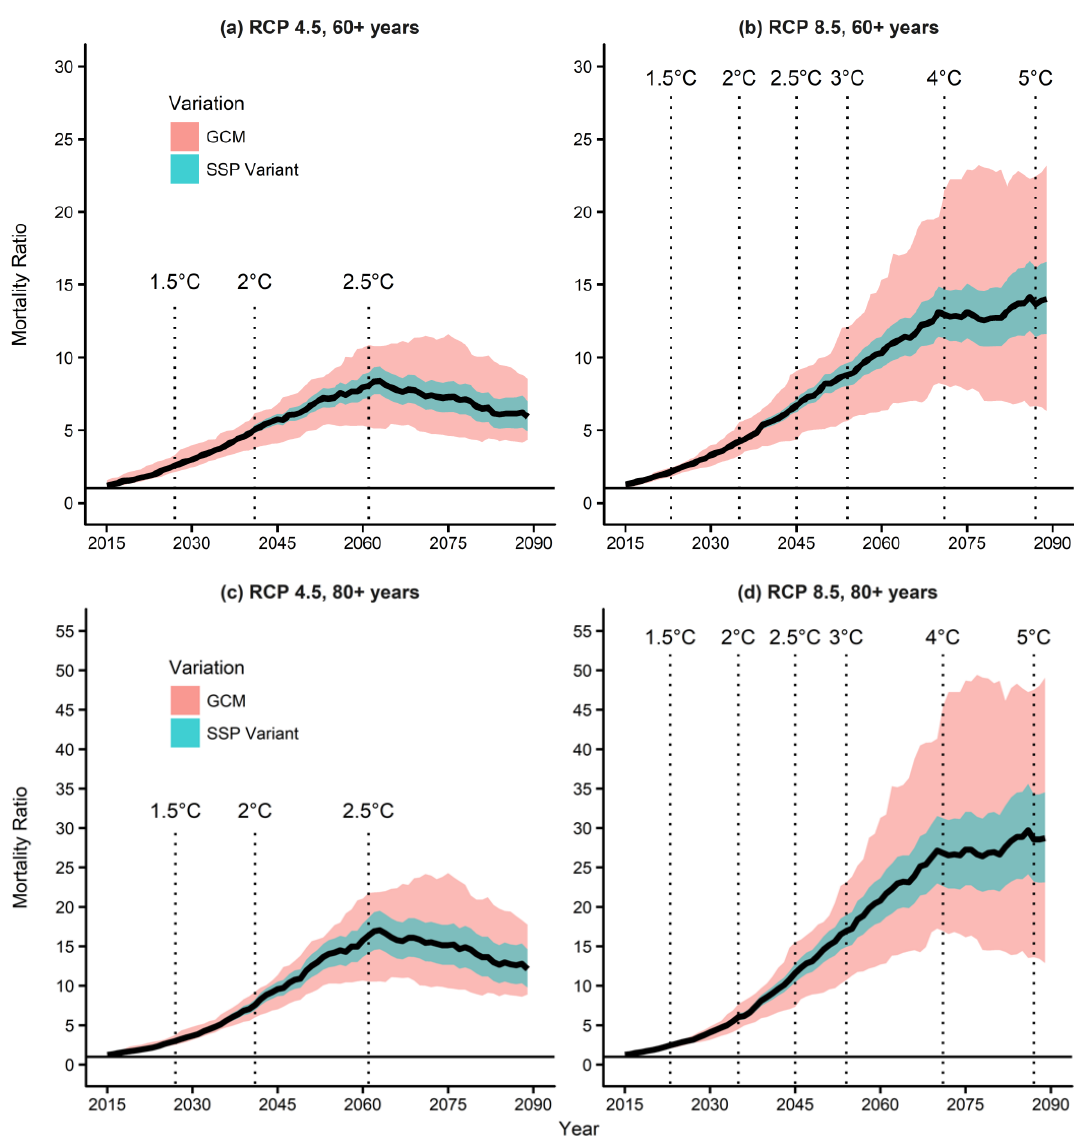
Figure 4. Mortality ratios according to temperature and population changes under different RCP and SSP scenarios: ( a ) RCP 4.5, individuals aged ≥ 60 years, ( b ) RCP 8.5, individuals aged ≥ 60 years, ( c ) RCP 4.5, individuals aged ≥ 80 years, and ( d ) RCP 8.5, individuals aged ≥ 80 years. GCM, general circulation model; RCP, Representative Concentration Pathway; SSP, shared Socioeconomic Pathway.